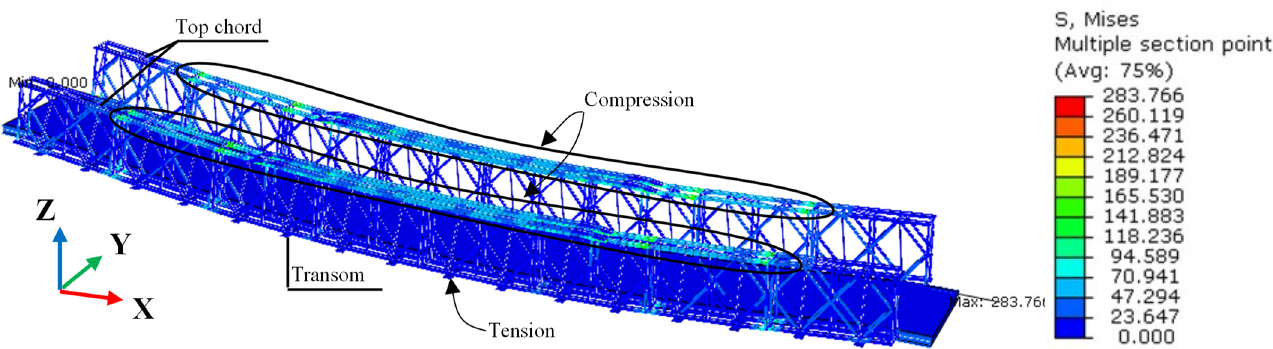
Figure 13. Compression and tension members—critical members.